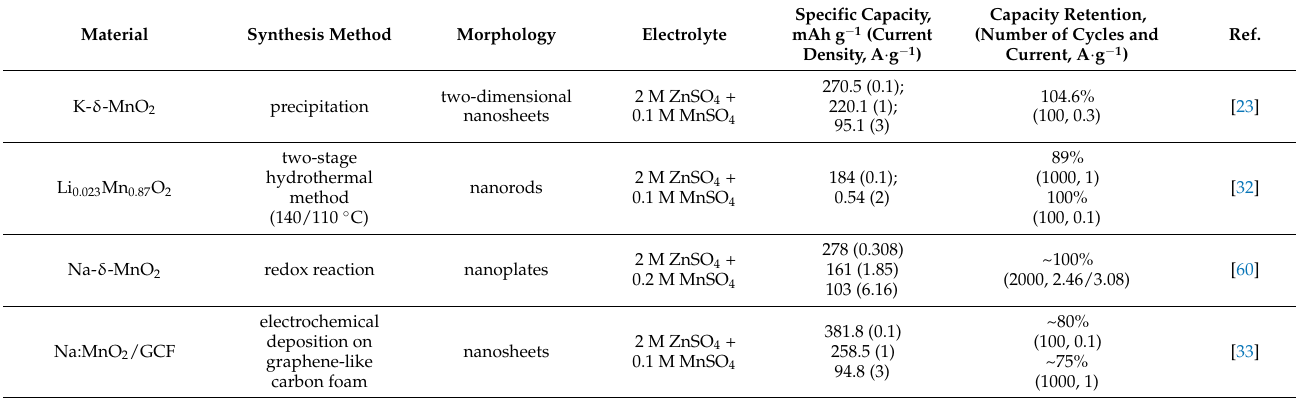
Table 1. Electrochemical performance of selected MnO 2 -based materials doped with metal ions as cathodes in